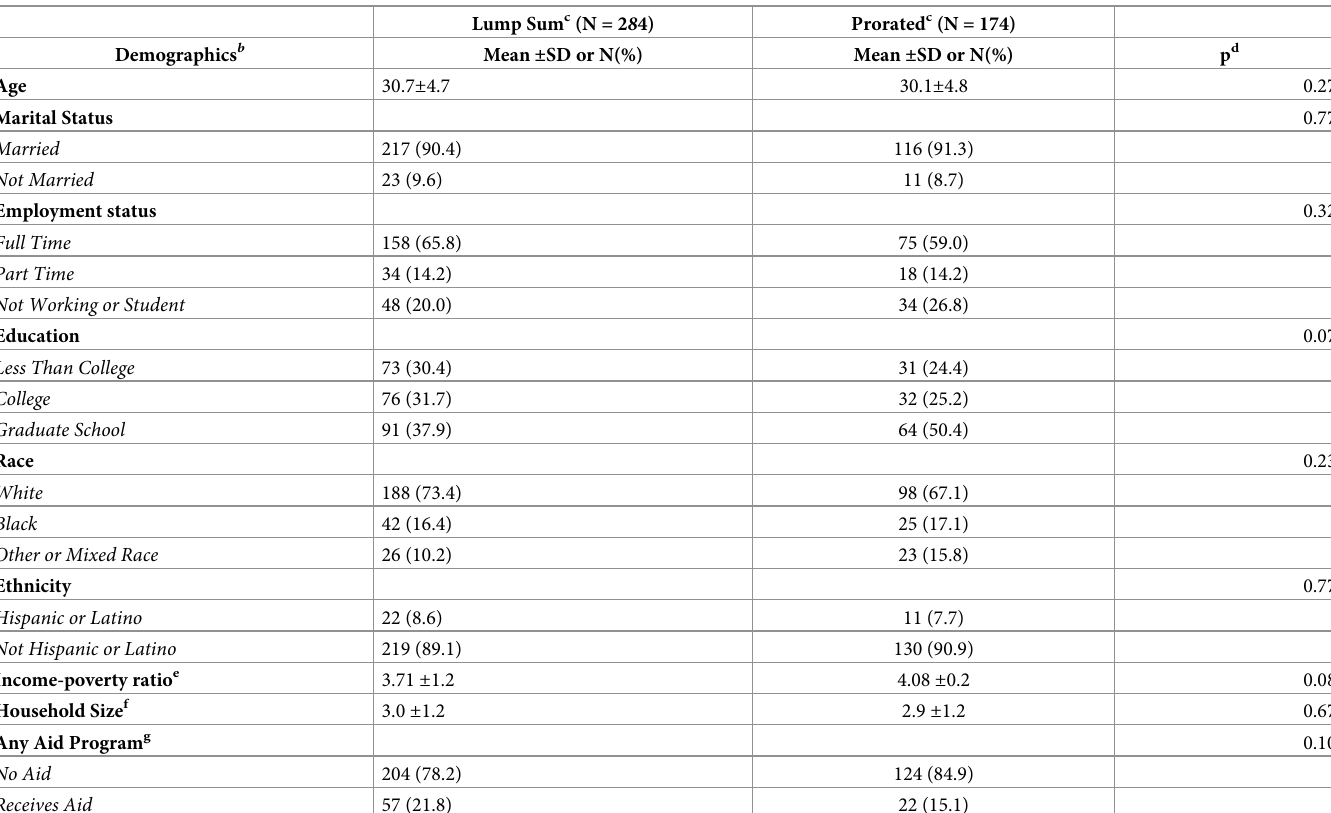
Table 1. Baseline sociodemographics of women in PEAS a under lump sum and prorated